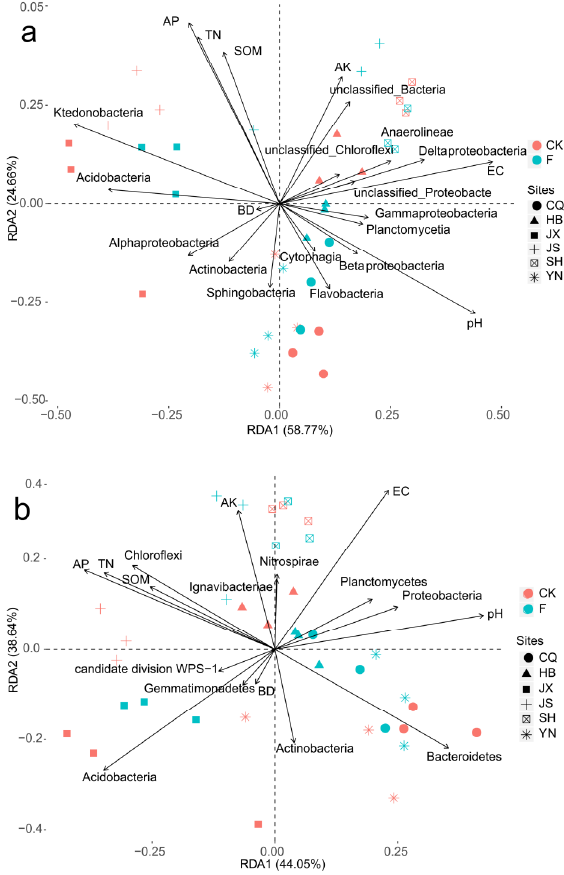
Figure 6. Redundancy analysis (RDA) based on the bacterial class ( a ) and phylum ( b ) data. JX = Jiangxi; JS = Jiangsu; HB = Hubei; CQ = Chongqing; YN = Yunnan; SH = Shanghai; CK = non-forested soils; F = forested soils; BD = bulk density; EC = electrical conductivity; AK = available potassium; TN = total nitrogen; AP = available phosphorus; SOM = soil organic matter.